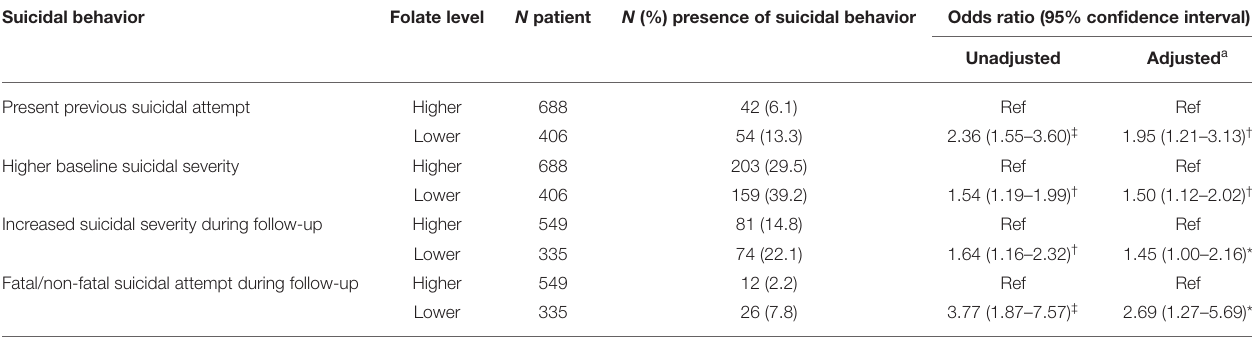
TABLE 4 | Associations of serum folate higher ( ≥ 6ng/mL) vs. lower ( < 6ng/mL) levels with suicidal behavior in patients with depressive disorder. Suicidal behavior